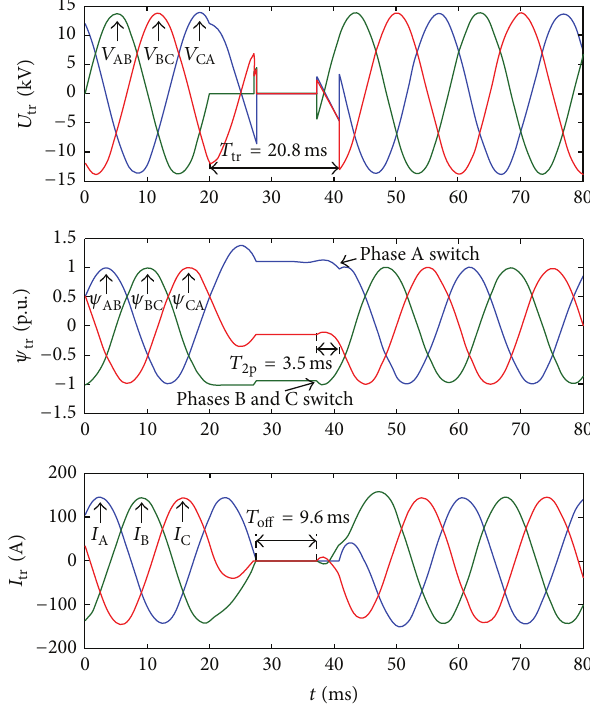
Figure 12: Waves of the transfer strategy with flux linkage DC com- ponent elimination. From the top to bottom, they are transformer voltages, transformer flux linkages, and load